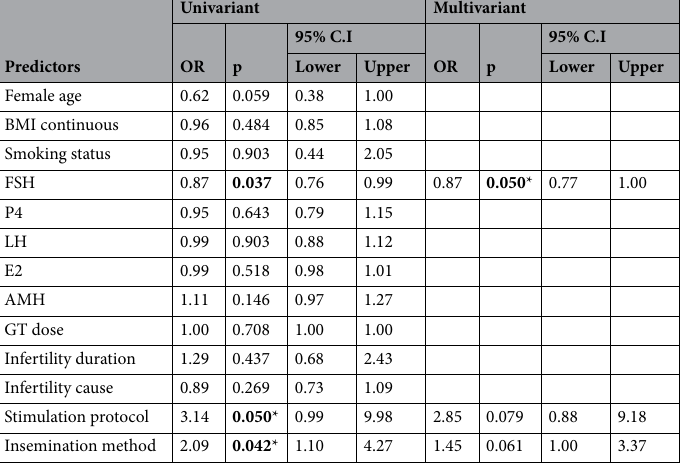
Table 4. Regression analysis of potential P4 level on the OR day predictors. BMI body mass index, FSH follicle stimulating hormone, LH luteinizing hormone, E2 estradiol, P4 progesterone, AMH anti-Mullerian hormone, GT gonadotropins, ART assisted reproductive technologies. *p <